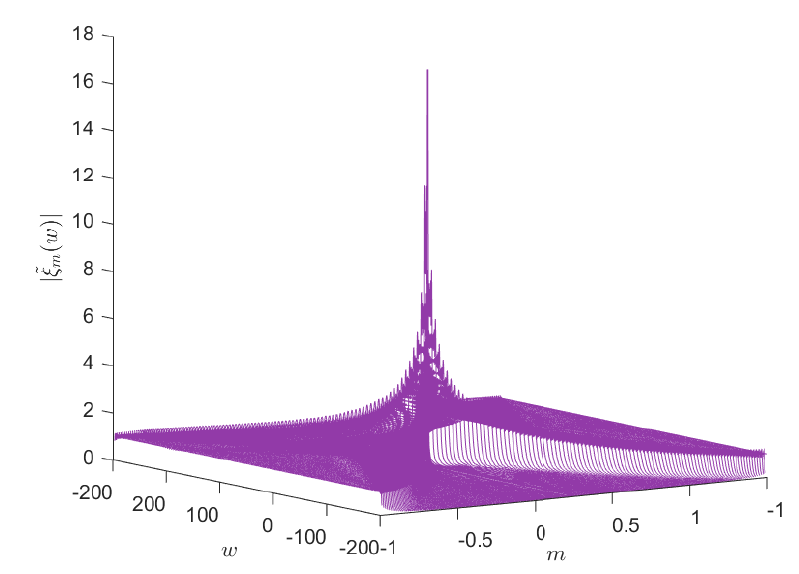
Figure 4. Simulation example of D-FrFT Figure 5. Gray image of the top view angle of